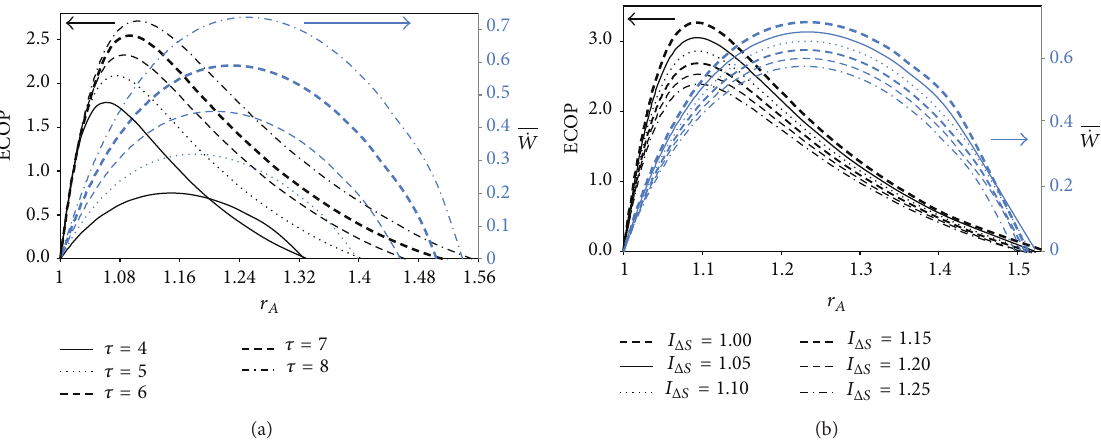
Figure 3: Variations of the ECOP and dimensionless power output with respect to Atkinson cycle ratio for (a) various 𝜏 , ( 𝐼 Δ𝑆 = 1.2 ); and (b) for various 𝐼 Δ𝑆 (𝜏 = 7) ( 𝑇 0 = 𝑇 𝐿 = 300 K, 𝑋 = (𝑁 𝐻1 + 𝑁 𝐻2 )/𝑁 𝑇 = 0.3 , and 𝜉 = 0.02